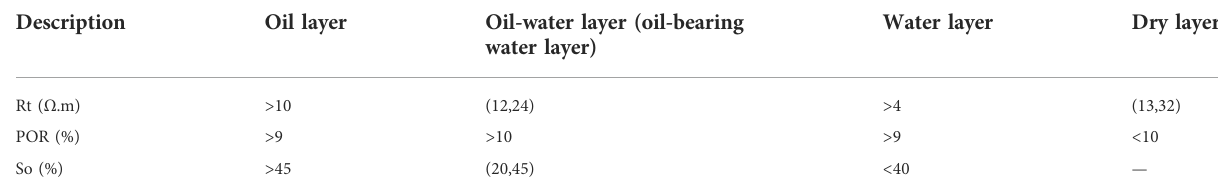
TABLE 4 Statistics of oil and water stratum interpretation